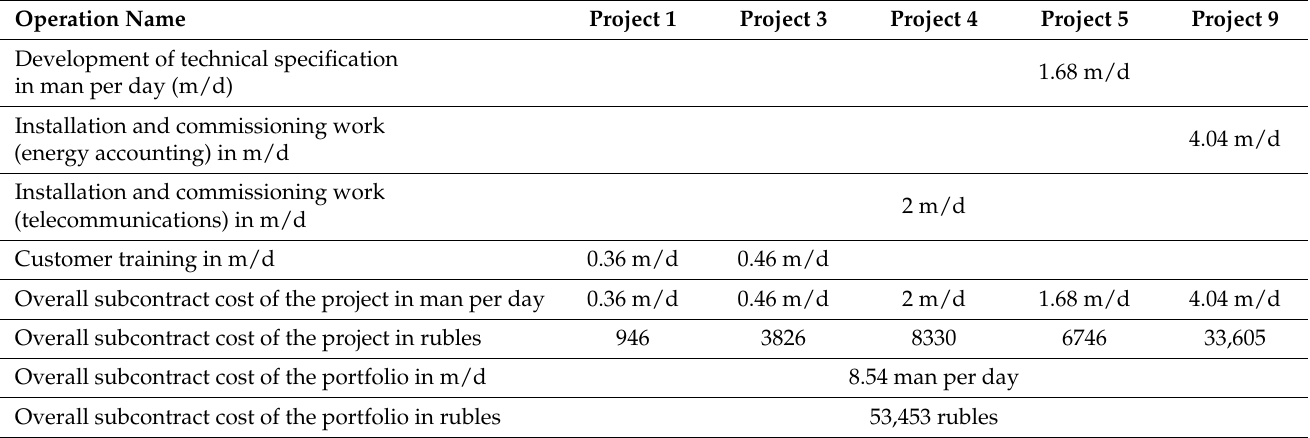
Table 7. Subcontracted resources’ cost allocation for the schedule provided by the IH method.